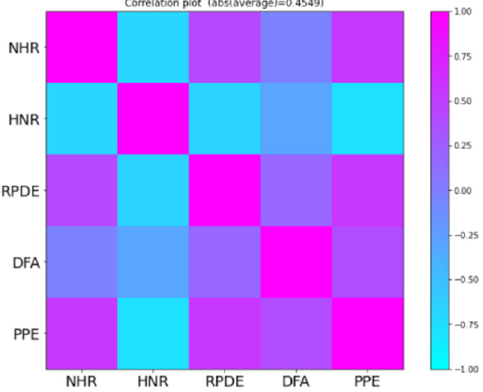
Figure 5. Correlation between selected features.